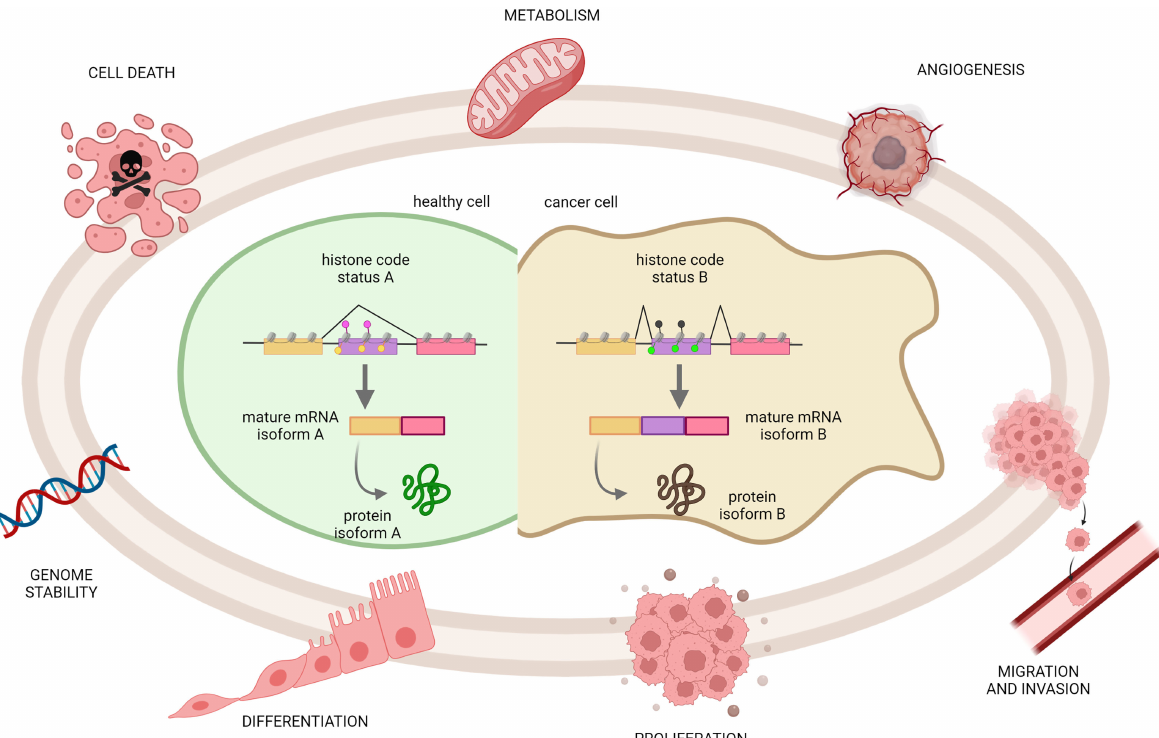
Figure 2. Genes undergoing alternative splicing produce functionally alternative products that can have dramatic effects on physiological processes and, consequently, can participate in the devel- opment or progression of cancer. The model represents how intragenic histone PTMs can drive distinct AS outcomes associated with common cancer hallmarks, such as genome instability, reduced cell death and differentiation, enhanced proliferation, metabolic reprogramming, and induced cell migration/invasion. Created with